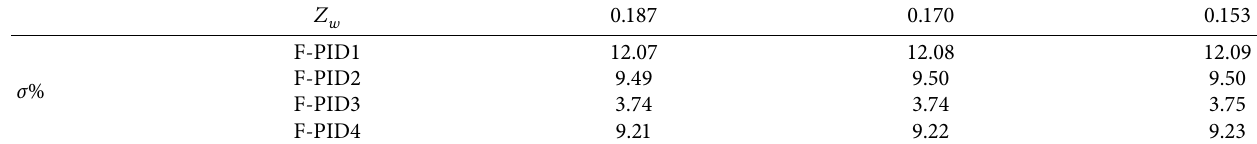
Table 8: Variation rule of overshoot with the hydrodynamic coefcient.